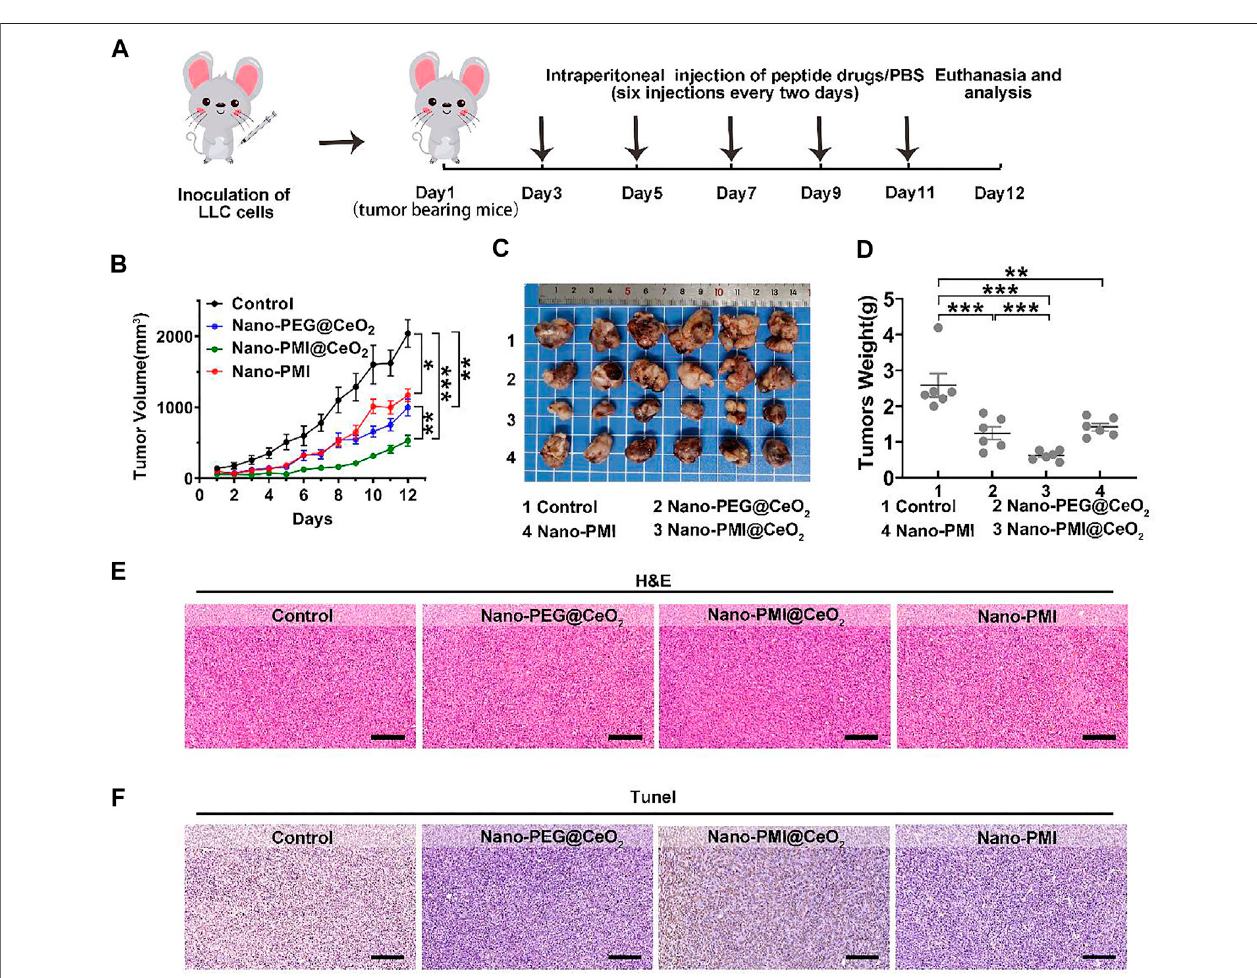
FIGURE 4 | Nano-PMI@CeO 2 in vivo antitumor activity. (A) Schematic depiction of the subcutaneous allograft lung cancer model and therapeutic process LLC allograftlungcancermodelwasestablishedbysubcutaneousinjectionLLCcells.Miceweretreatedwithintraperitonealinjectionevery2 dayssixtimeswithnanoparticle drugs (2 mg/kg) or PBS. (B) Tumor sizes were measured by a vernier caliper every day. Tumor volume data were shown as mean ± SE ( n = 6/group). p values were calculatedby t -test(*, p < 0.05;**, p < 0.01;***, p < 0.001). (C) Photographsand (D) averageweightsoftumorswerecollectedattheendoftheexperiment( n =6). p values were calculated by t -test (*, p < 0.05; **, p < 0.01; ***, p < 0.001). (E&F) Allograft tumors from mice after the 12 days of treatment staining by H&E (E) and TUNEL (F) . (Scale bar: 200 μ